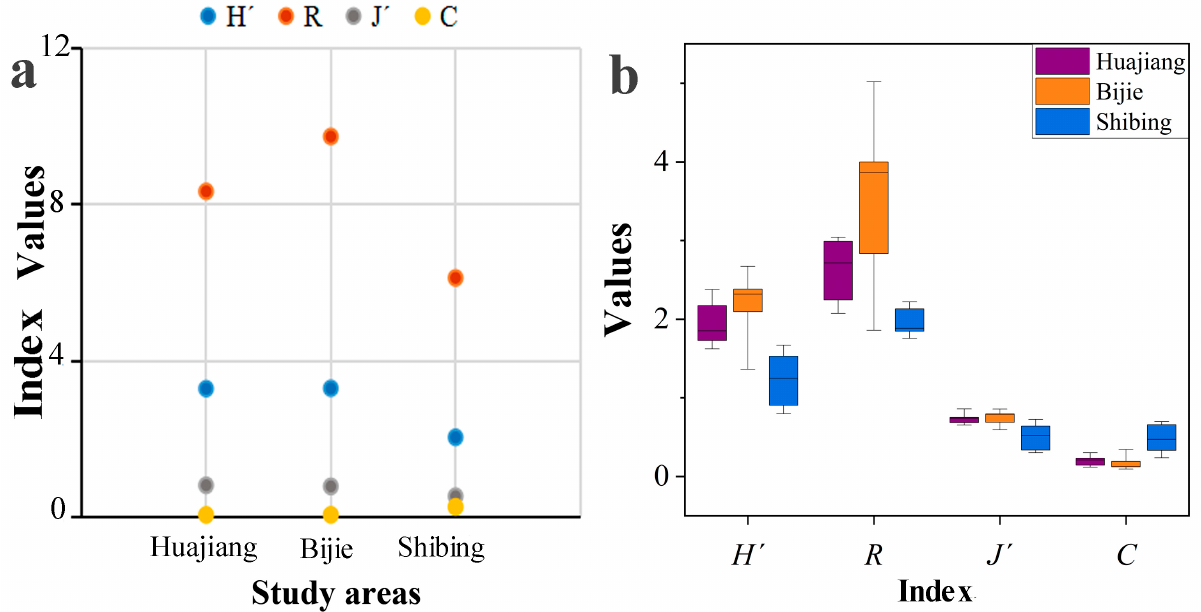
Figure 7. Community diversity of typhlocybine leafhoppers in three different study areas (( a ): the total values of three study areas ( b ): the values of fifteen sample plots of the three study areas).